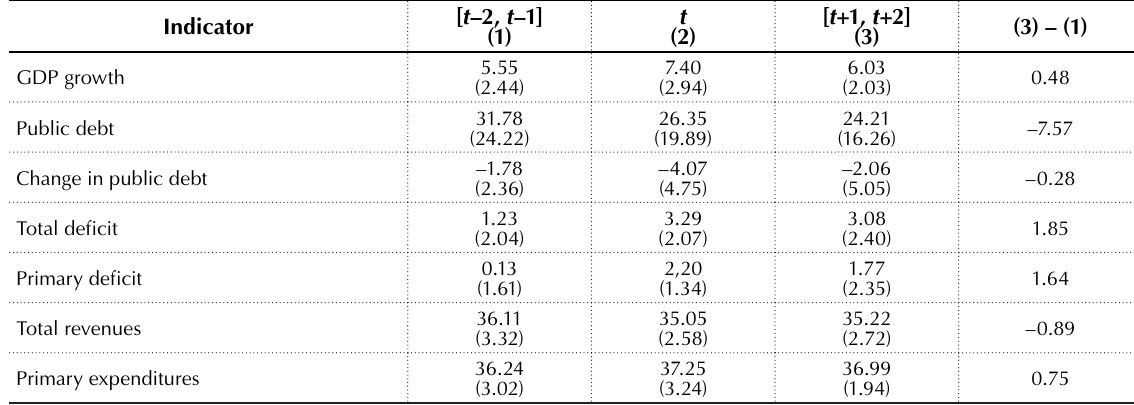
Table 1. Expansionary fiscal adjustments in the EU countries with emerging market economies: size and